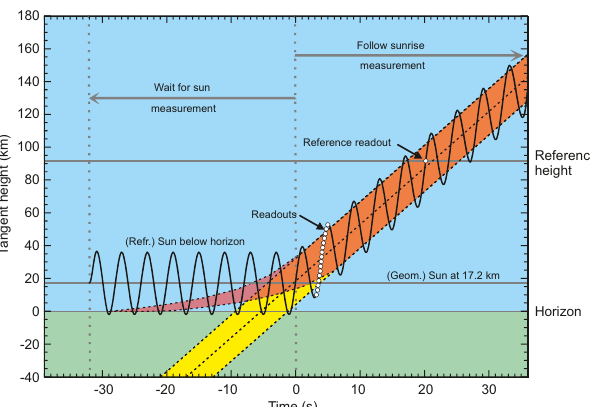
Figure 1. Illustration of the solar scan strategy (modified version of Fig. 2 in Bramstedt et al., 2012). The orange/yellow area indicates the size of the refracted/geometrical sun. The black curve shows the scan as function of time, relative to the time where the geometrical sun reaches 17.2km (which is the sun-fixed event used in mission planning for this measurement). The white dots indicate (as an ex- ample for one upward scan) the position of individual readouts. The corresponding reference readout for an upward scan is also shown.